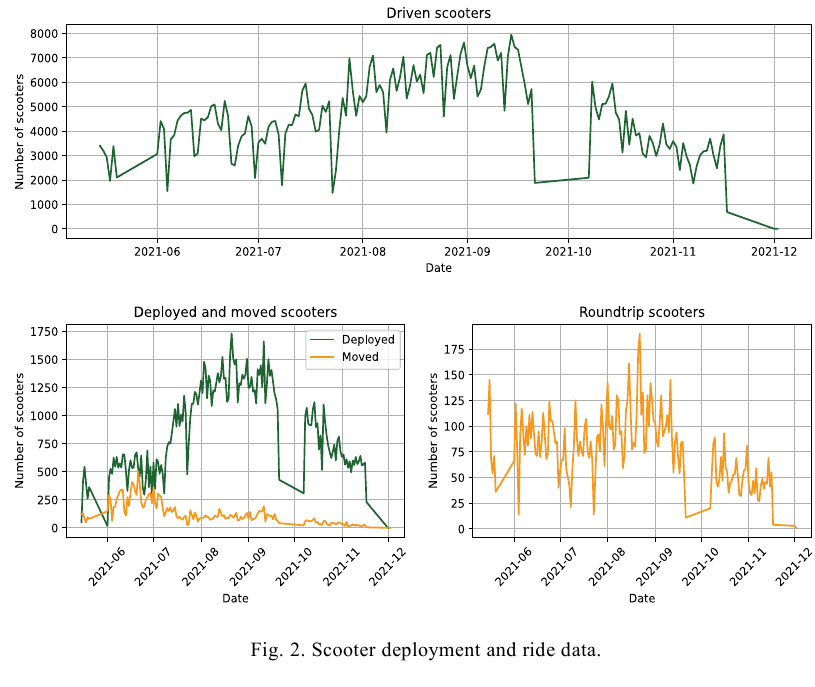
Fig. 2. Scooter deployment and ride data.